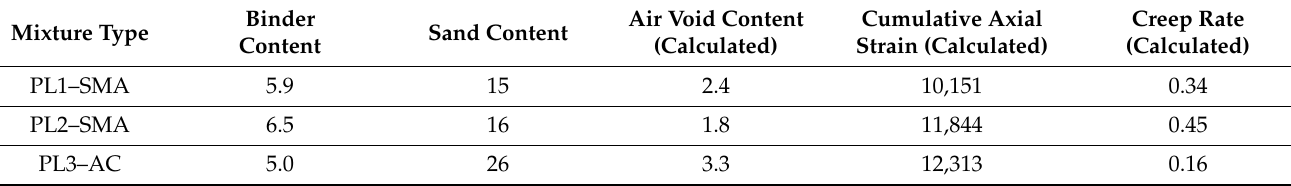
Table 6. Calculation results for selected